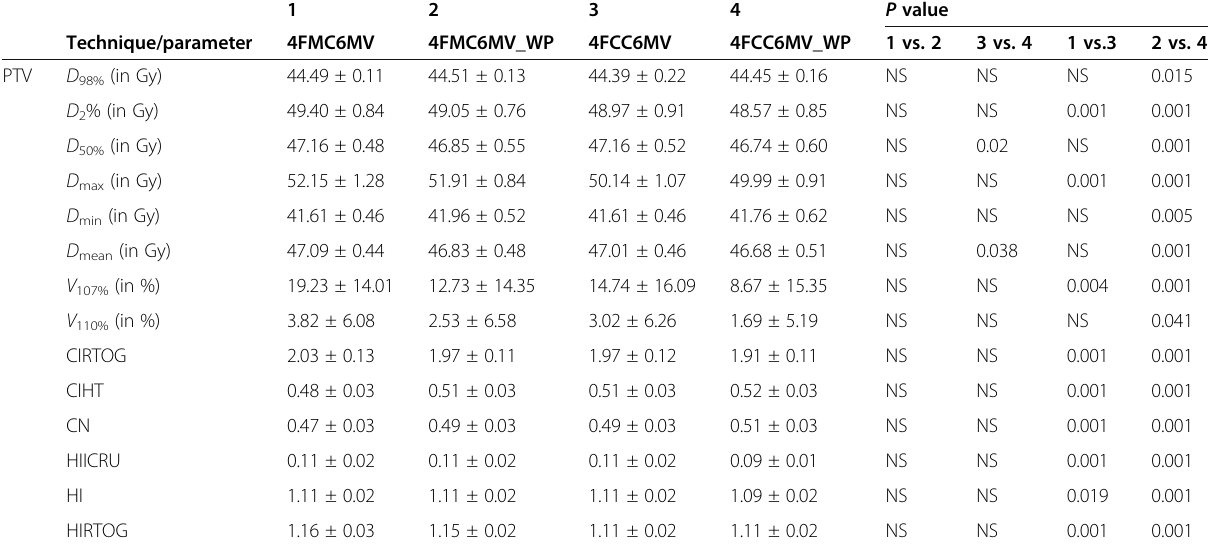
Table 1 DVH analysis of PTV